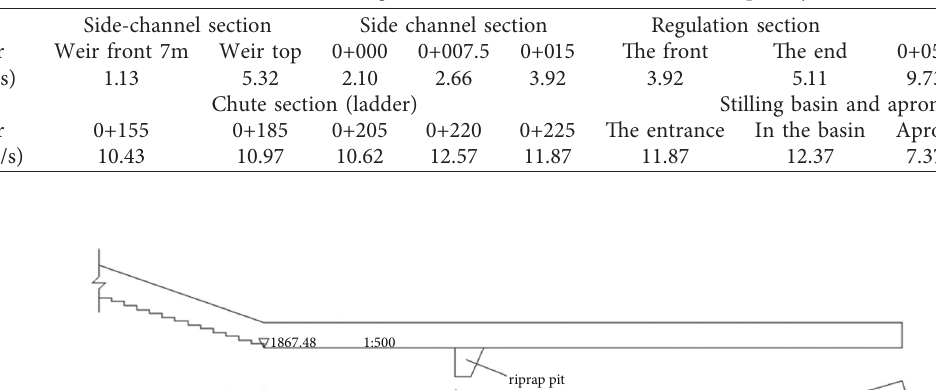
Figure 7: Flow state in the spillway under different conditions. (a) Flow state under a 10-year flood. (b) Flow state under a 20-year flood. (c) Flow state under a 30-year flood. Table 2: The average flux of classical cross section in the spillway.